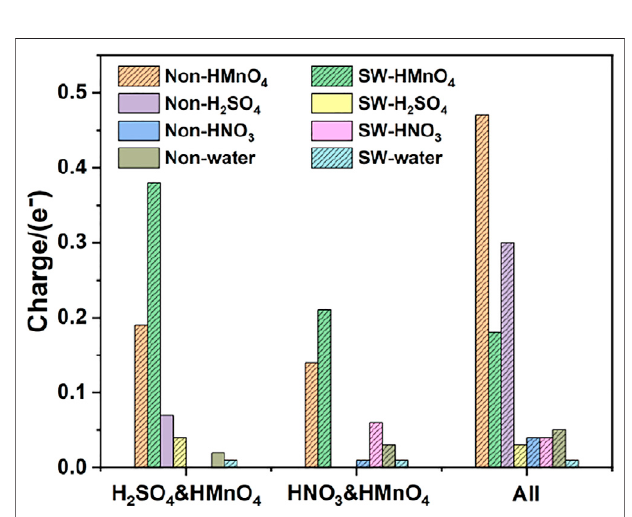
FIGURE 10 | Charge of HMnO 4 in the mix-component in aqueous condition. The shadow indicates that this value is negative.